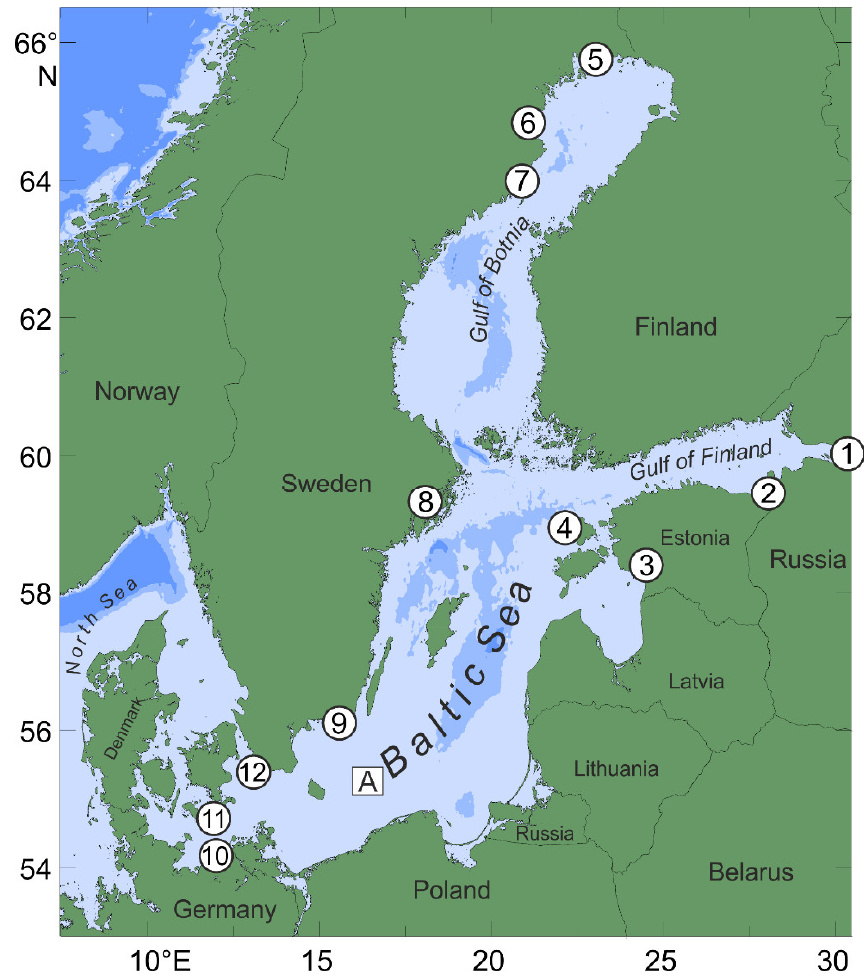
Figure 1. Locations of the tide gauges (circles) and reanalysis grid point (square) with the wind and pressure data.